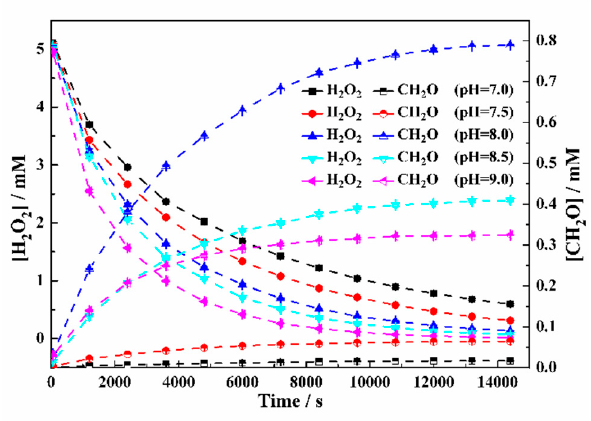
Figure 5. The concentration of H 2 O 2 ([H 2 O 2 ] 0 = 5 mM) and CH 2 O as a function of reaction time in the presence of Tris ([Tris] 0 = 100 mM) with the catalyst dosage of 4.0 × 10 5 m − 1 at 298.15K in pH from 7.0 to 9.0.